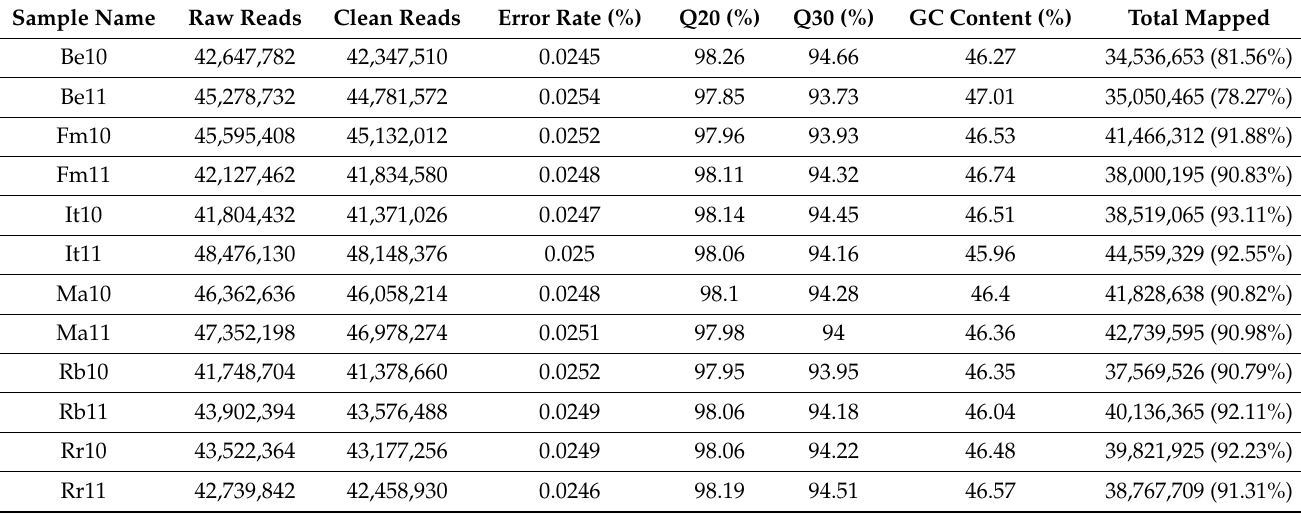
Table 1. RNA-Seq data quality of all 12